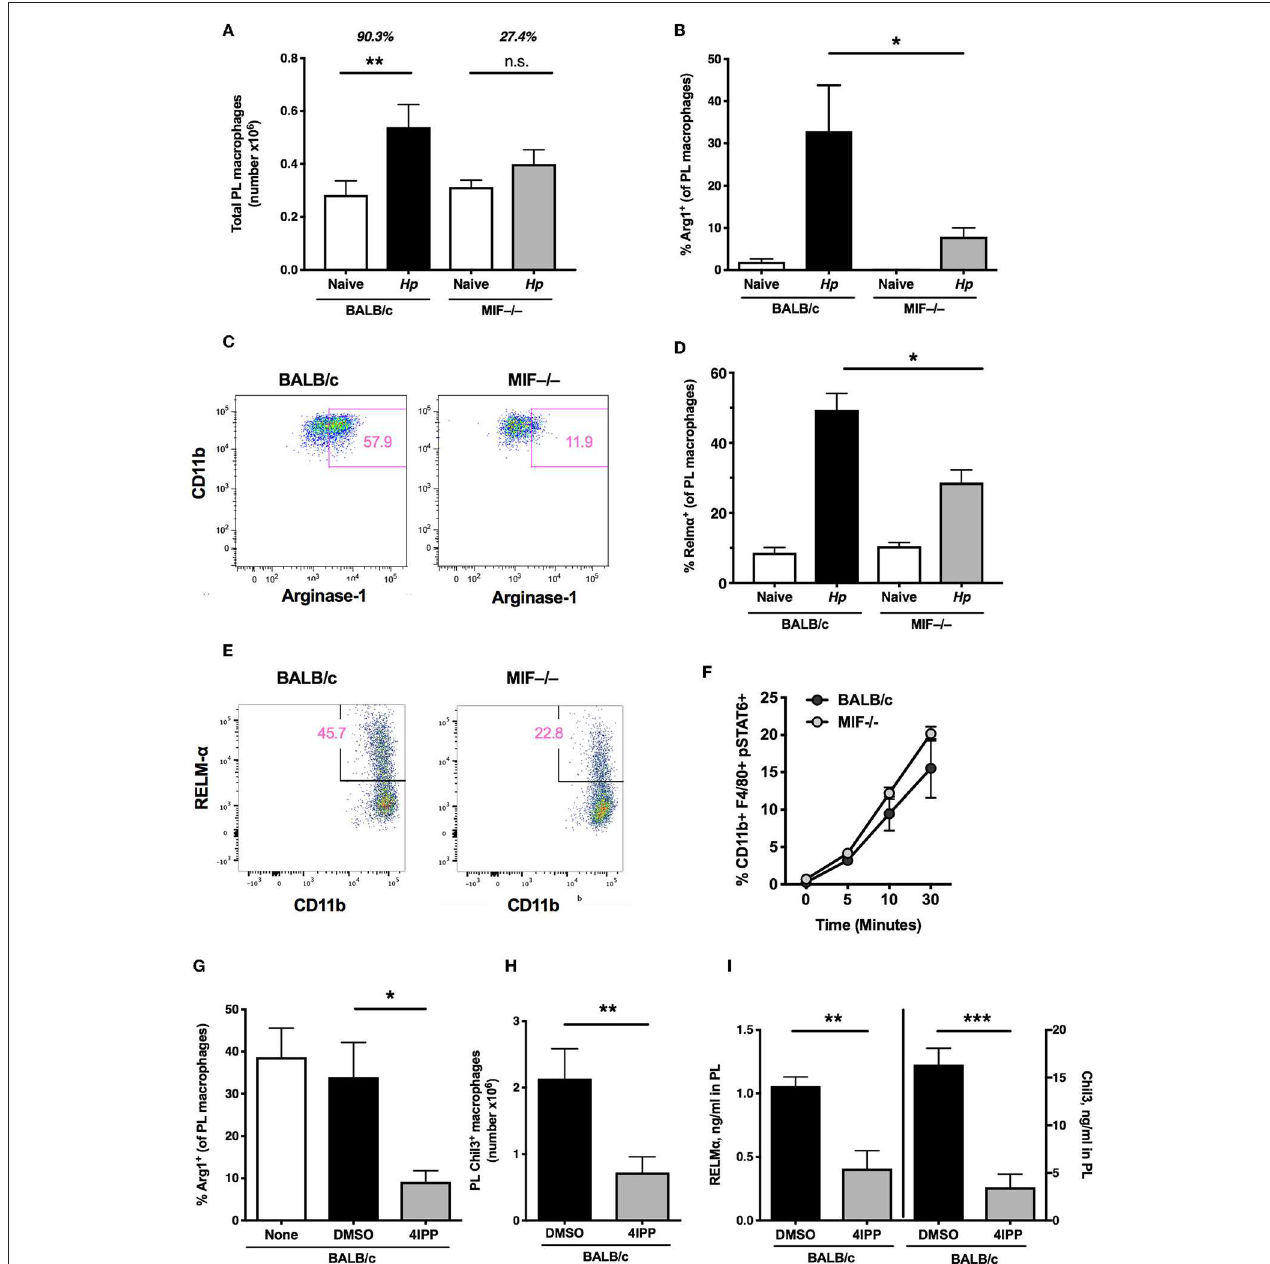
FIGURE 4 | Type 2 myeloid responses in MIF-deficient mice. (A) MIF − / − mice have a reduced capacity for induction of macrophages after helminth infection. Total macrophage (CD11b + F4/80 + ) numbers within the peritoneal cavity of BALB/c and MIF − / − mice at day 6 post-infection with H. polygyrus , or in naïve mice. Data are representative of two independent experiments. (B) Percentage of peritoneal macrophages that are Arginase + in BALB/c and MIF − / − mice at day 3 post-infection with H. polygyrus , or in naïve mice. Results are combined from two experiments with similar results. (C) Representative flow cytometry plots of CD11b and Arginase-1 staining in peritoneal macrophages from BALB/c and MIF − / − mice. (D) Percentage of peritoneal macrophages that are RELM α + in BALB/c and MIF − / − mice at day 6 post-infection with H. polygyrus , or in naïve mice. Data are representative of two independent experiments. (E) Representative flow cytometry plots of CD11b and RELM- α staining in peritoneal macrophages from BALB/c and MIF − / − mice. (F) STAT6 phosphorylation of bone marrow-derived macrophages in response to 20ng/ml recombinant IL-4, measured by flow cytometry at the times indicated. (G) The MIF inhibitor, 4IPP, can replicate the macrophage deficit of MIF − / − mice in BALB/c mice after H. polygyrus infection. Percentage of peritoneal macrophages that are Arginase-1 + in DMSO- or 4IPP- treated BALB/c mice at day 3 post-infection with H. polygyrus , or in naïve mice receiving no treatment. Data are representative of two independent experiments. (H) Number of peritoneal macrophages that are Chil3 + in DMSO- or 4IPP-treated BALB/c mice at day 7 post-infection with H. polygyrus . Results are combined from two experiments with similar results. (I) Levels of RELM α and Chil3 measured by ELISA in peritoneal lavage fluid of DMSO- or 4IPP- treated BALB/c mice at day 7 post-infection with H. polygyrus . Data are representative of two independent experiments. * p < 0.05, ** p < 0.01, *** p < 0.001.